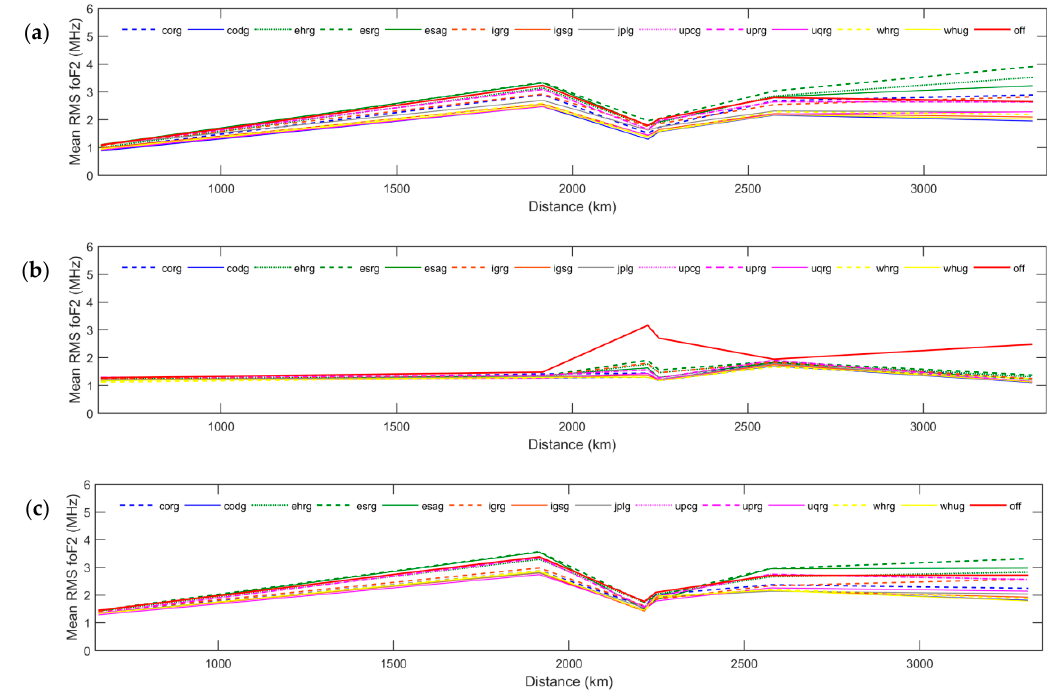
Figure 9. Mean RMS of the differences between fo F 2 values measured at the ionosondes and estimated using GIMs versus the distance of the ionosondes pairs considering one-week data: ( a ) test week (020-026 / 2015); ( b ) low (166-172 / 2015); ( c ) high (288-294 / 2015) ionospheric electron content. Remote Sens. 2020 , 12 , x FOR PEER REVIEW 11 of 18